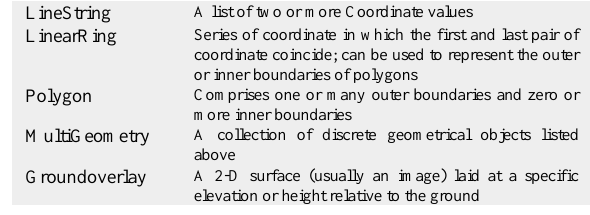
Table 3. KML geometrical object type (Chien and Tan. 2011).